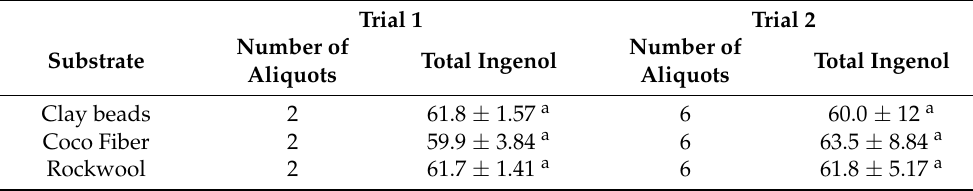
Table 1. Mean and standard deviation of total ingenol (mg/kg) measured in aliquots of 24 plants in two independent hydroponic cultivations of E. peplus in three substrates (rockwool, coco fiber, and clay beads). Student’s comparison of means was applied with 95% confidence; means that do not share a letter are significantly